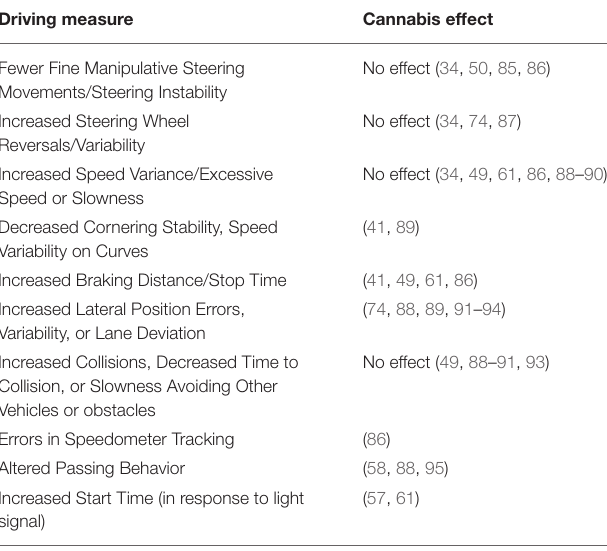
TABLE 2 | Impairment of driving behaviors by